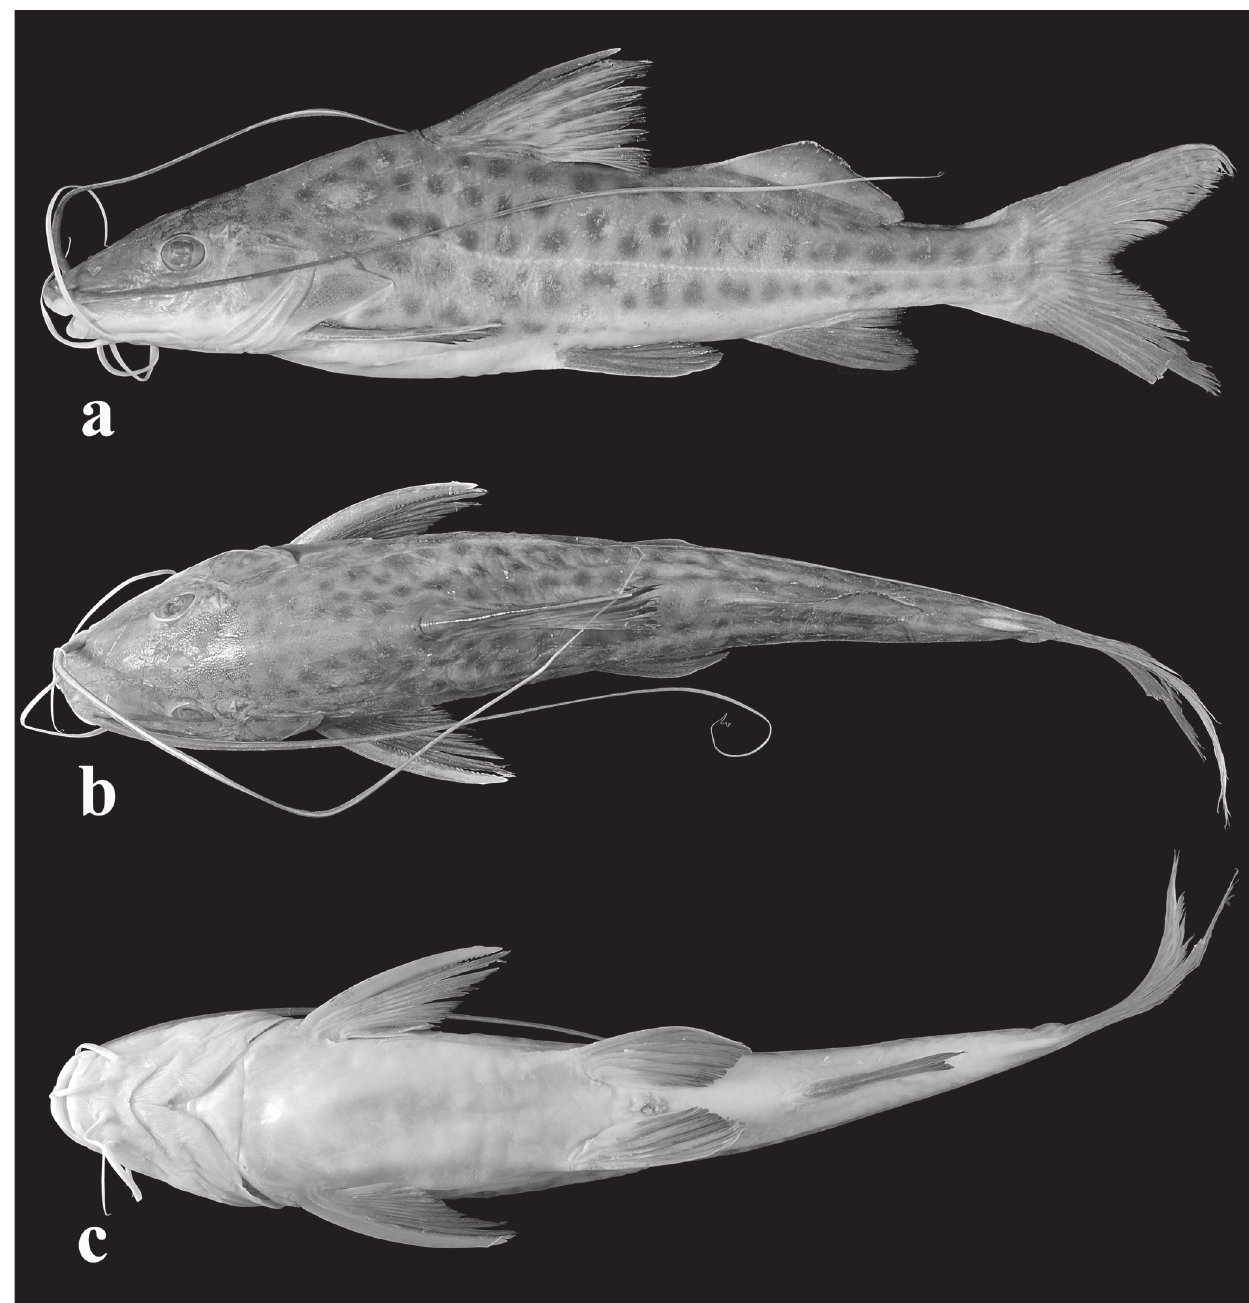
Fig. 1. Pimelodus multicratifer , holotype, MZUSP 91287, 198.0 mm SL, Brazil, São Paulo State, Pariquera-Açú, confluence of rios Pariquera and Pariquera-Mirim, near mouth of the rio Ribeira de Iguape, in lateral ( a ), dorsal ( b ), and ventral ( c )